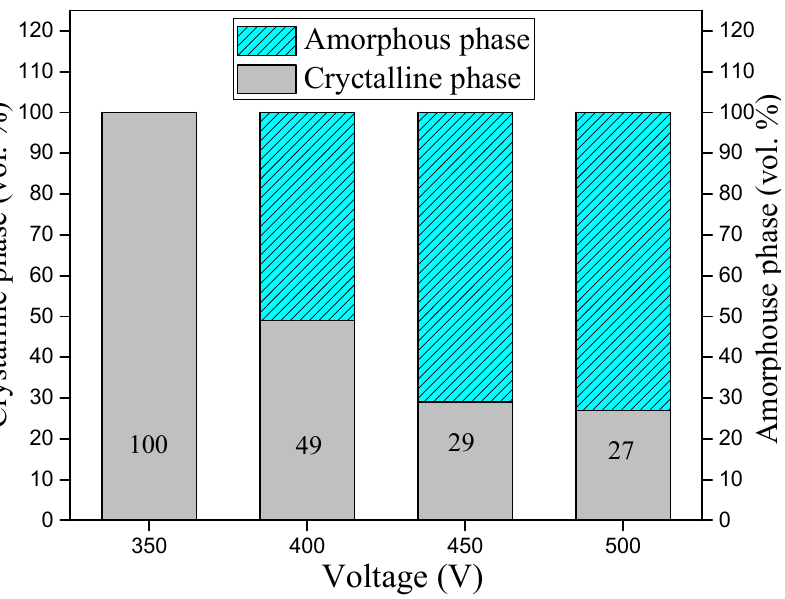
Figure 7. Diagram of the ratio of amorphous and crystalline phases in the